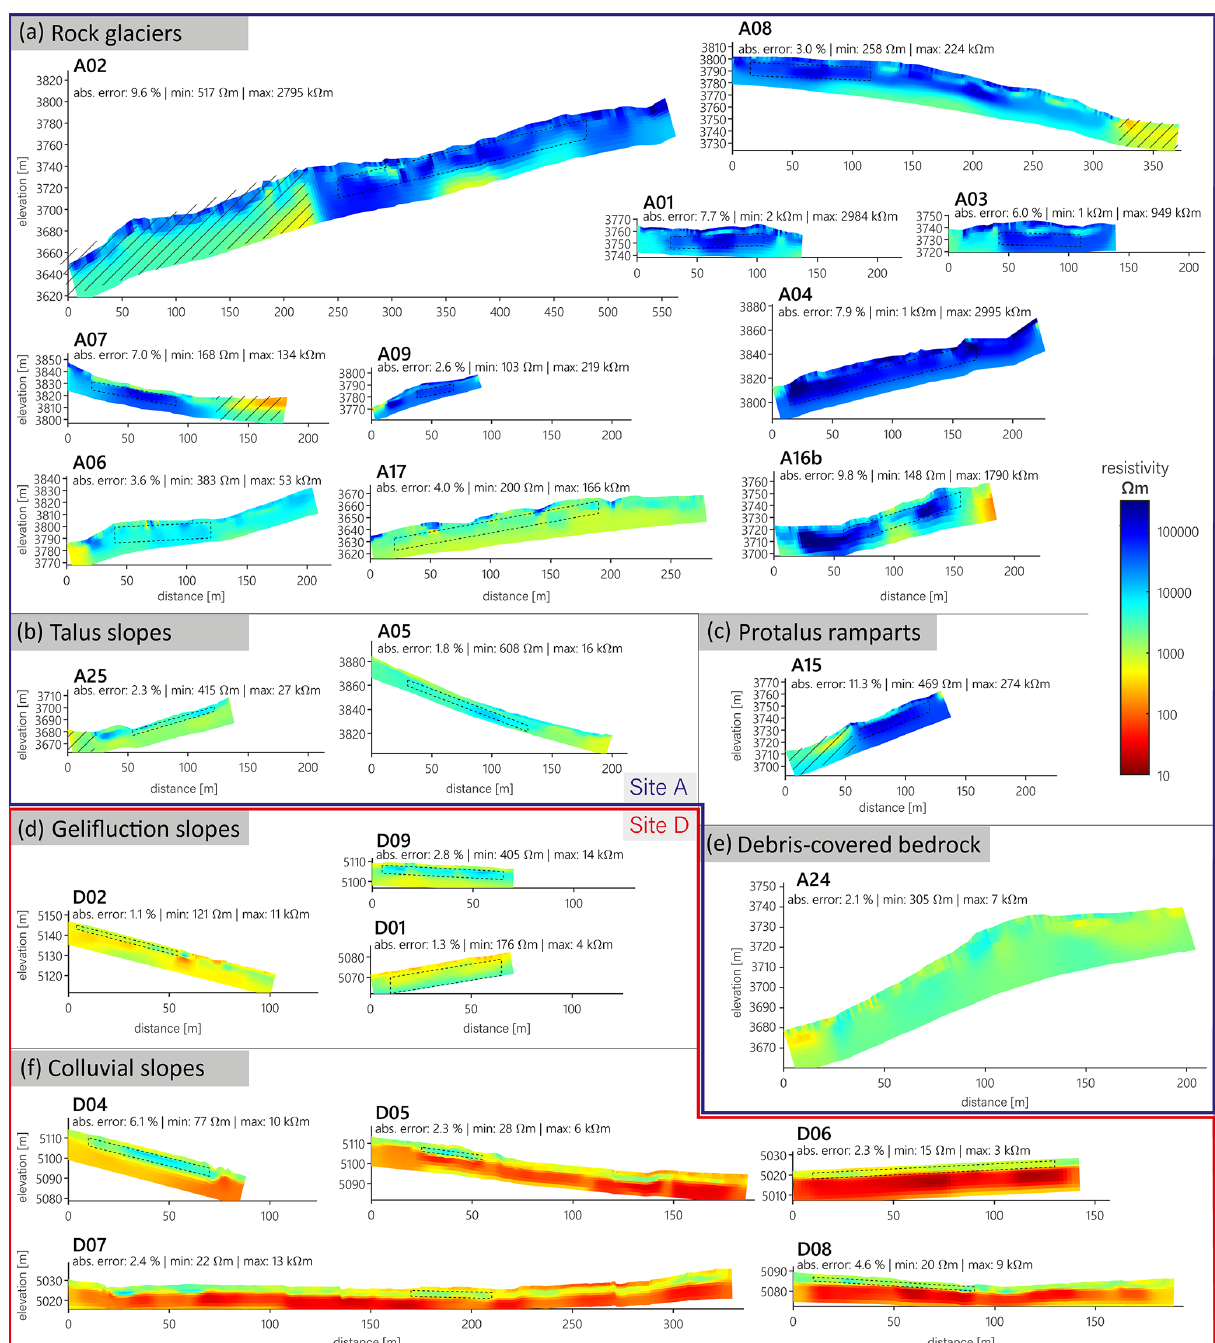
Figure A1. Inverted tomograms of all ERT profiles for Site A and Site D.